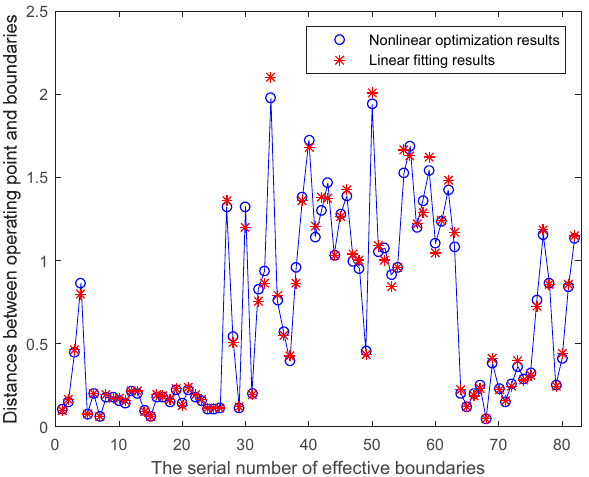
Figure 3. The distances between the operating point and all effective boundaries.